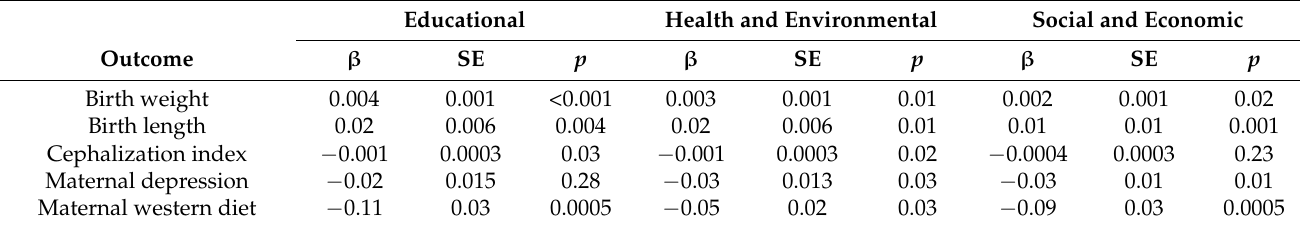
Table 4. Associations between domains of neighborhood level child opportunity and maternal and infant outcomes. Educational Health and